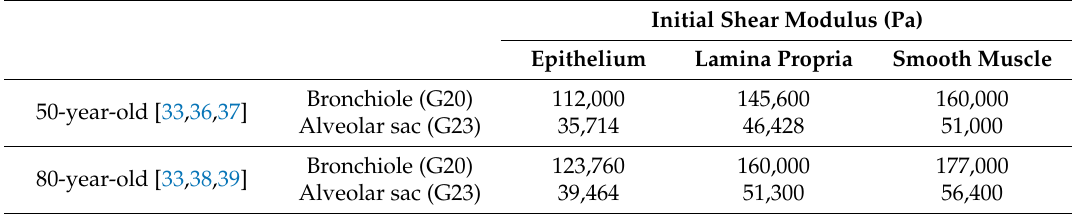
Table 2. Material properties of each layer of tissue for 50-year-old and 80-year-old